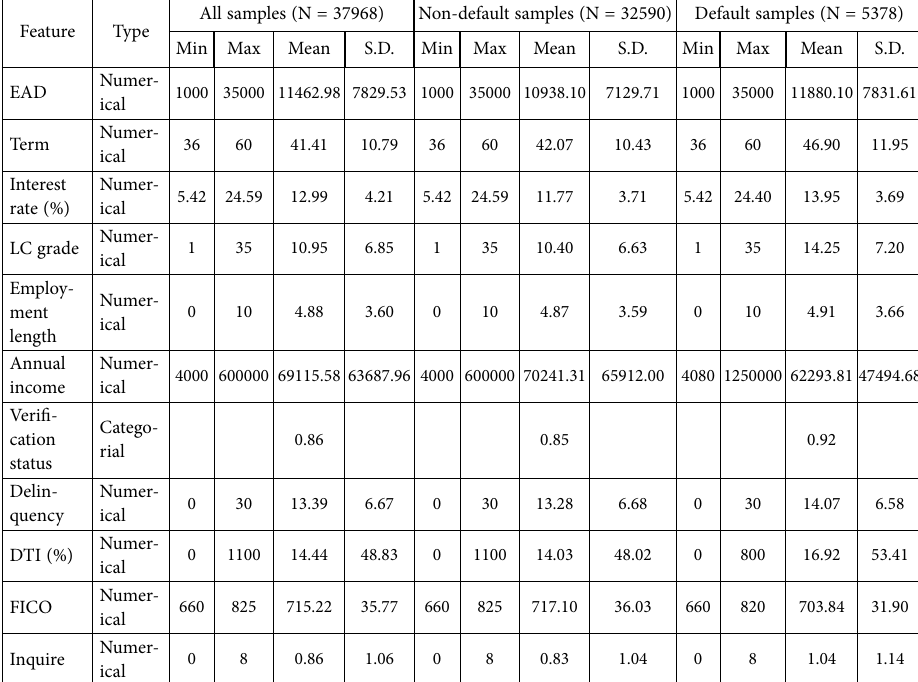
Table 1. Summary statistics of Lending Club